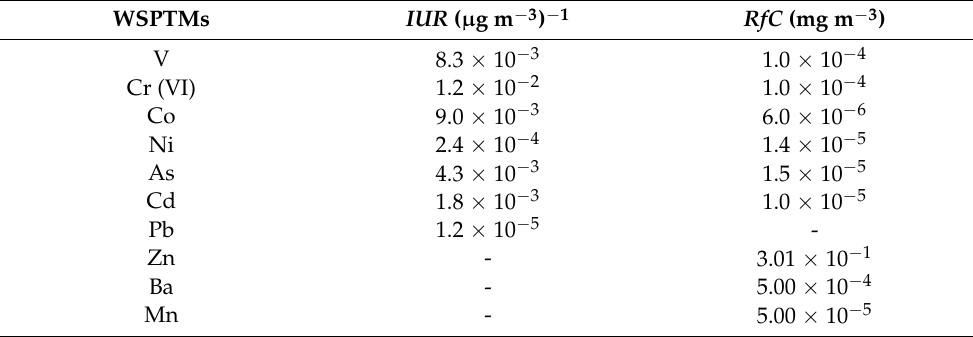
Table 4. RfC and IUR values [44] for different water-soluble potentially toxic metals